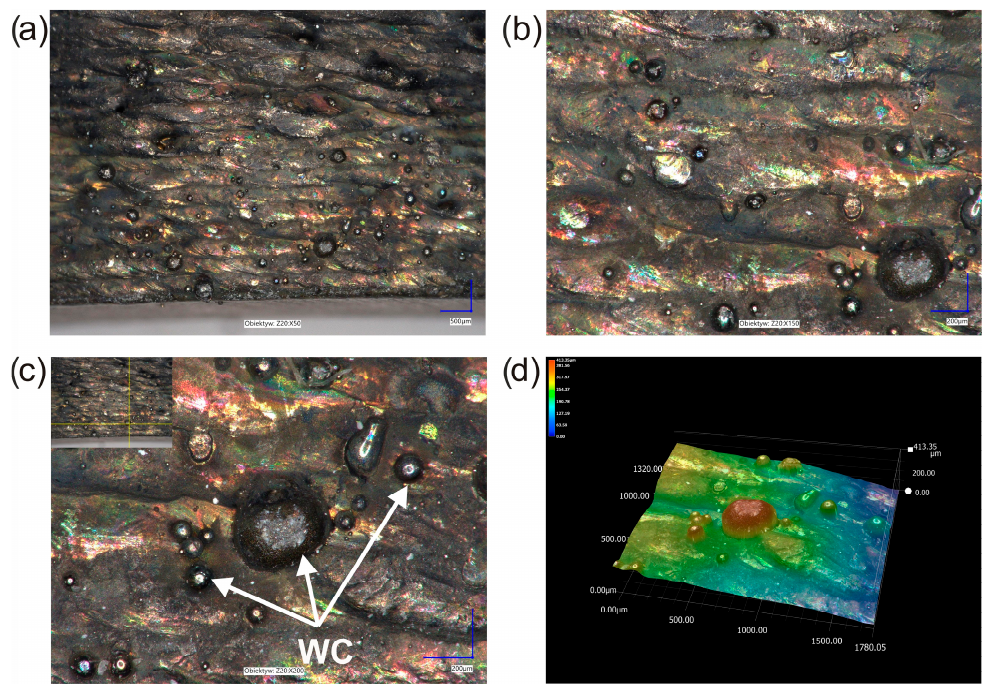
Figure 13. The surface morphology of the specimen laser-alloyed with a laser beam power of 1.3 kW: ( a – c ) images recorded by the digital microscope at various magnifications, ( d ) 3D image of the surface topography; the arrows indicate WC particles.